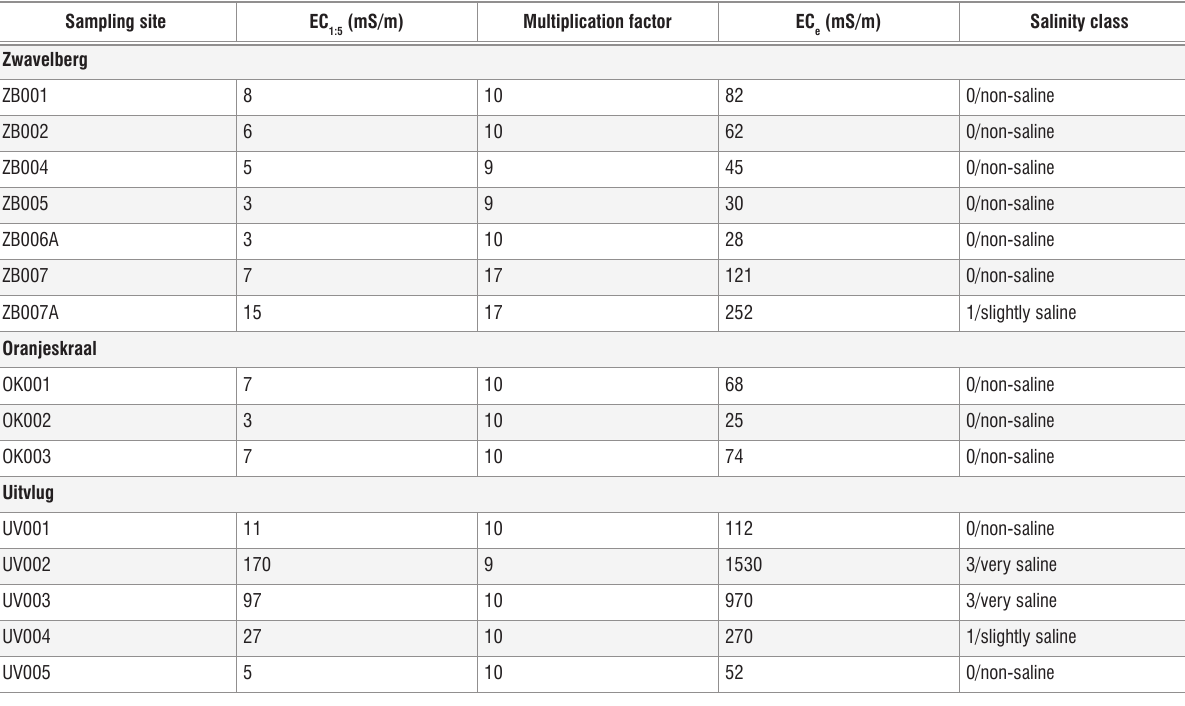
Topsoil salinity